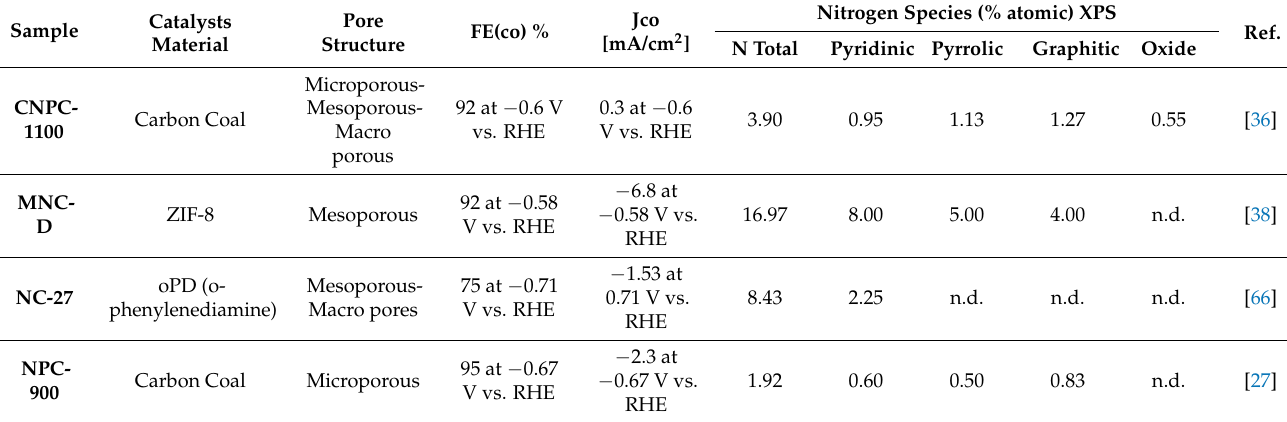
Table 3. Comparison between pore structure, quantity, and distribution of N